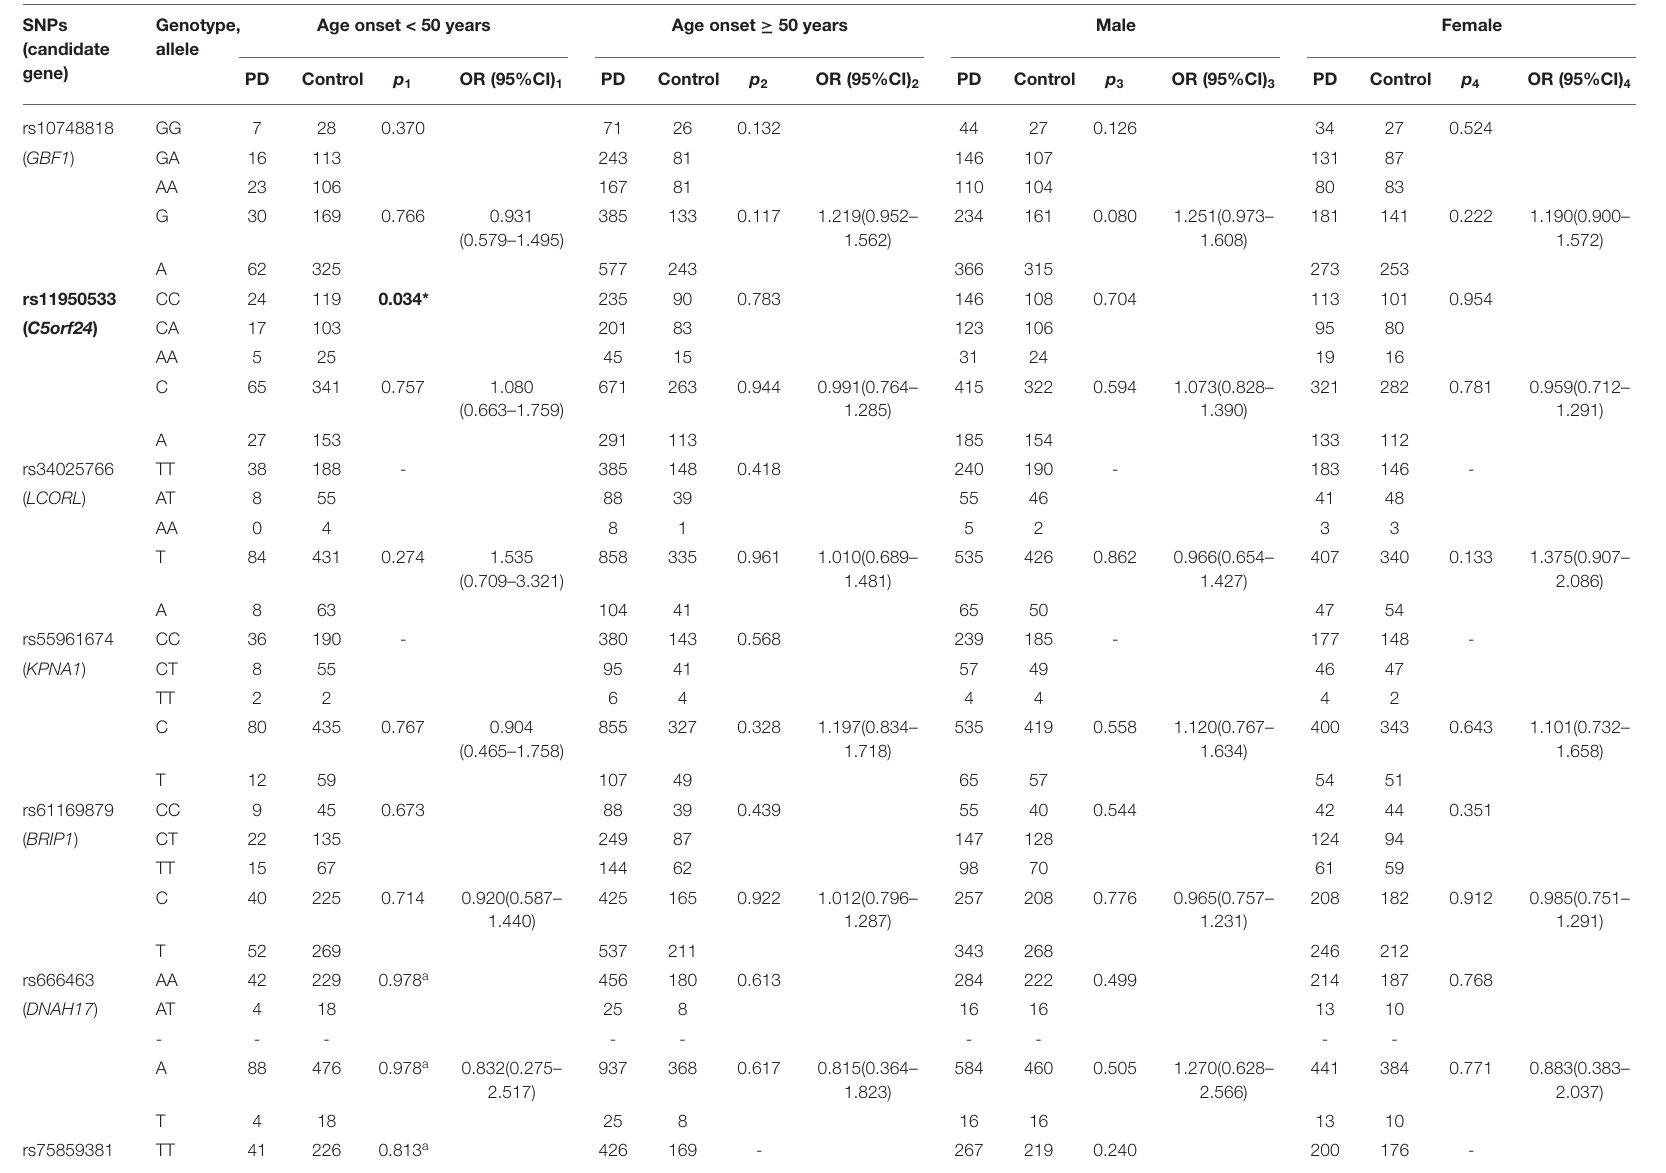
TABLE 2 | Age-stratified analysis and sex-stratified analysis of 12